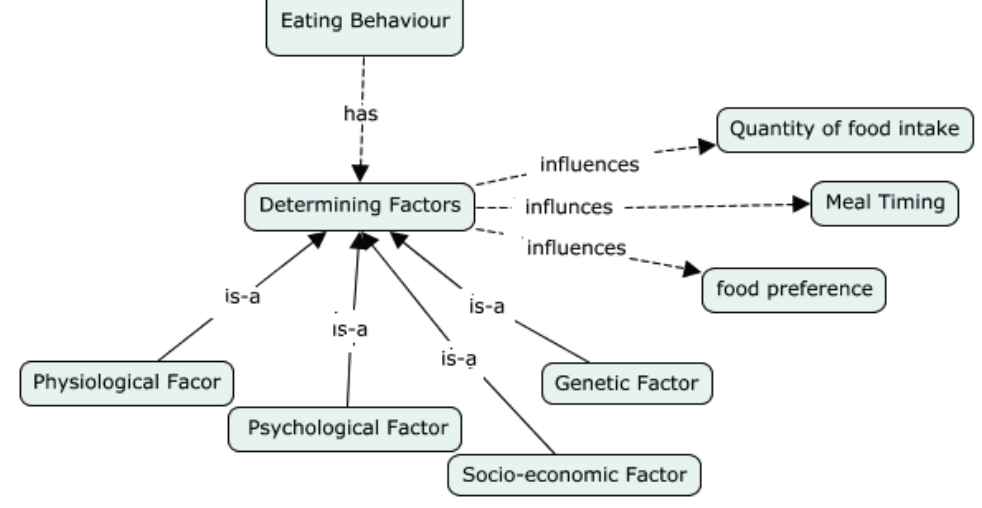
Figure 6. Conceptual map representing the interactions between determining factors of Eating Behavior with other